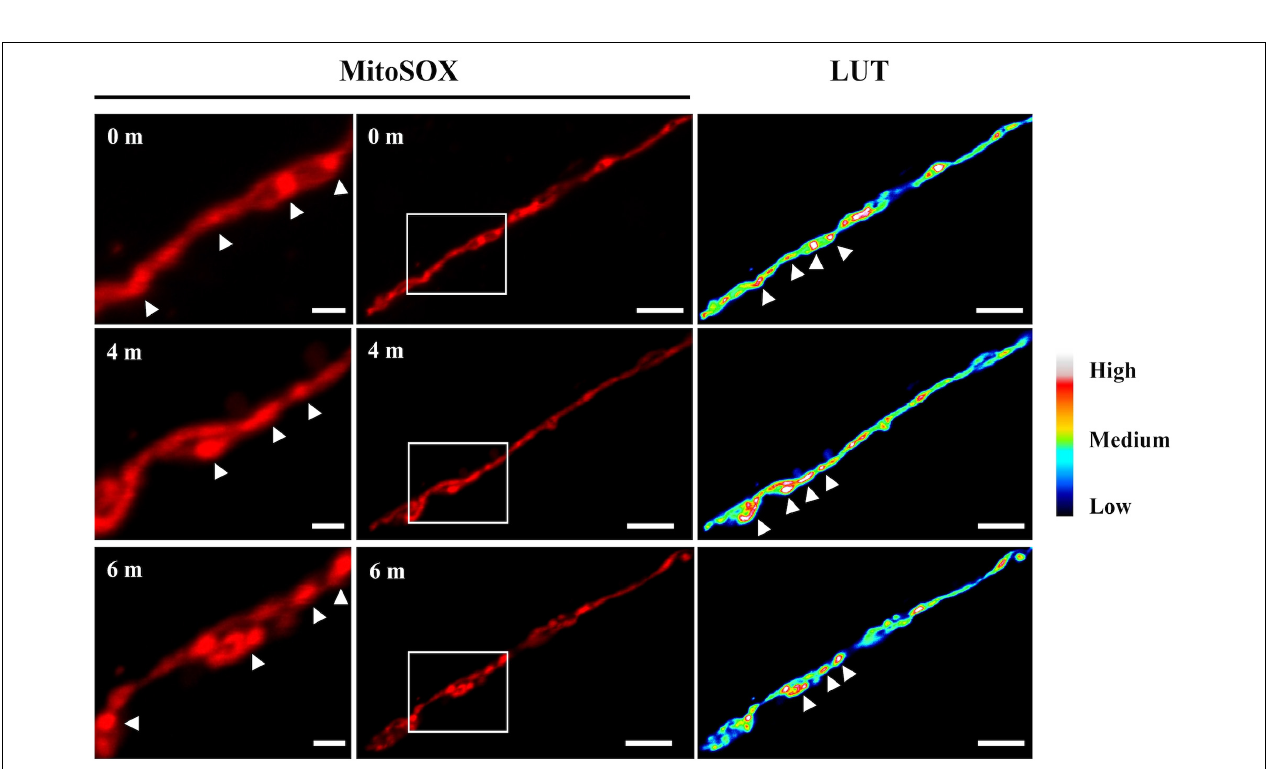
FIGURE 11 | Time course observation of (cid:49) dnmA mitochondria stained with MitoSOX. Mycelia from strain TVG1 ( (cid:49) dnmA ) grown for 14 h in supplemented glucose minimal medium was stained with MitoSOX, as indicated in section “Materials and Methods,” and then illuminated at 0, 4 and 6 min and observed by using confocal microscopy (center panels). Right panels show the relative quantification of the fluorescence intensity (LUT). Left panels show a magnification of squared regions in the central panels, where higher fluorescence intensity regions are indicated by white arrowheads. White bars = 5 µ m.